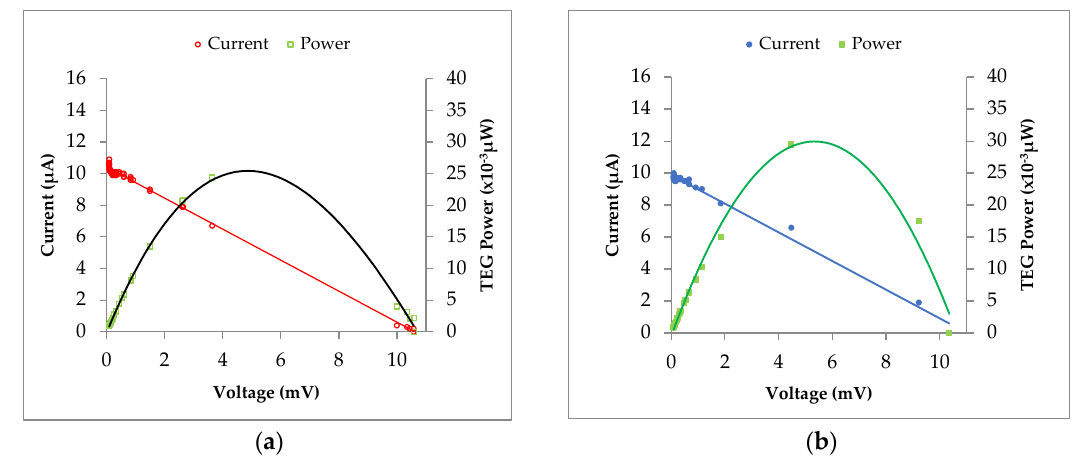
Figure 12. Characteristics of P-V and I-V in TEG; ( a ) reflected HM, ( b ) transmitted CM.